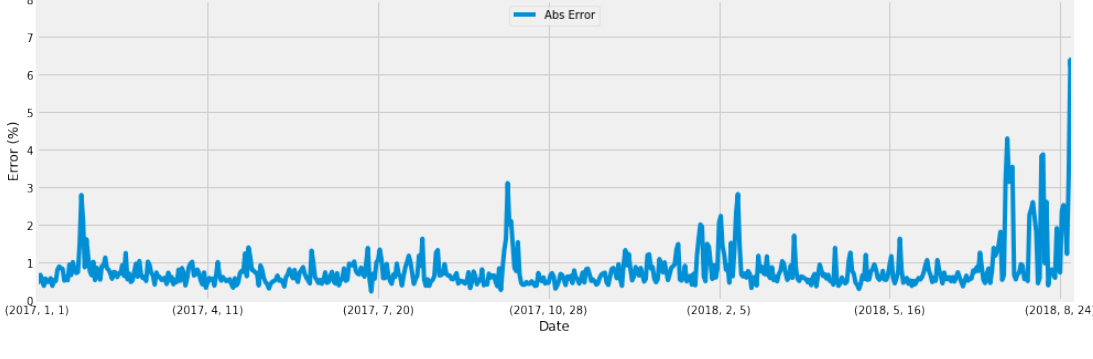
Figure 20. Ensembled method error